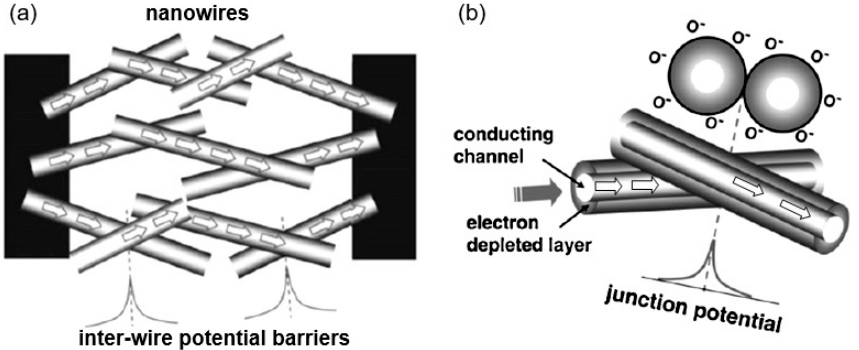
Figure 23. ( a ) Schematic diagrams for multi-nanowire-based chemical sensors; ( b ) schematic illustration of the gas sensing mechanism in a network of nanowires. Reproduced with permission from Vomiero et al. [294]. Copyright 2007: American Chemical Society.